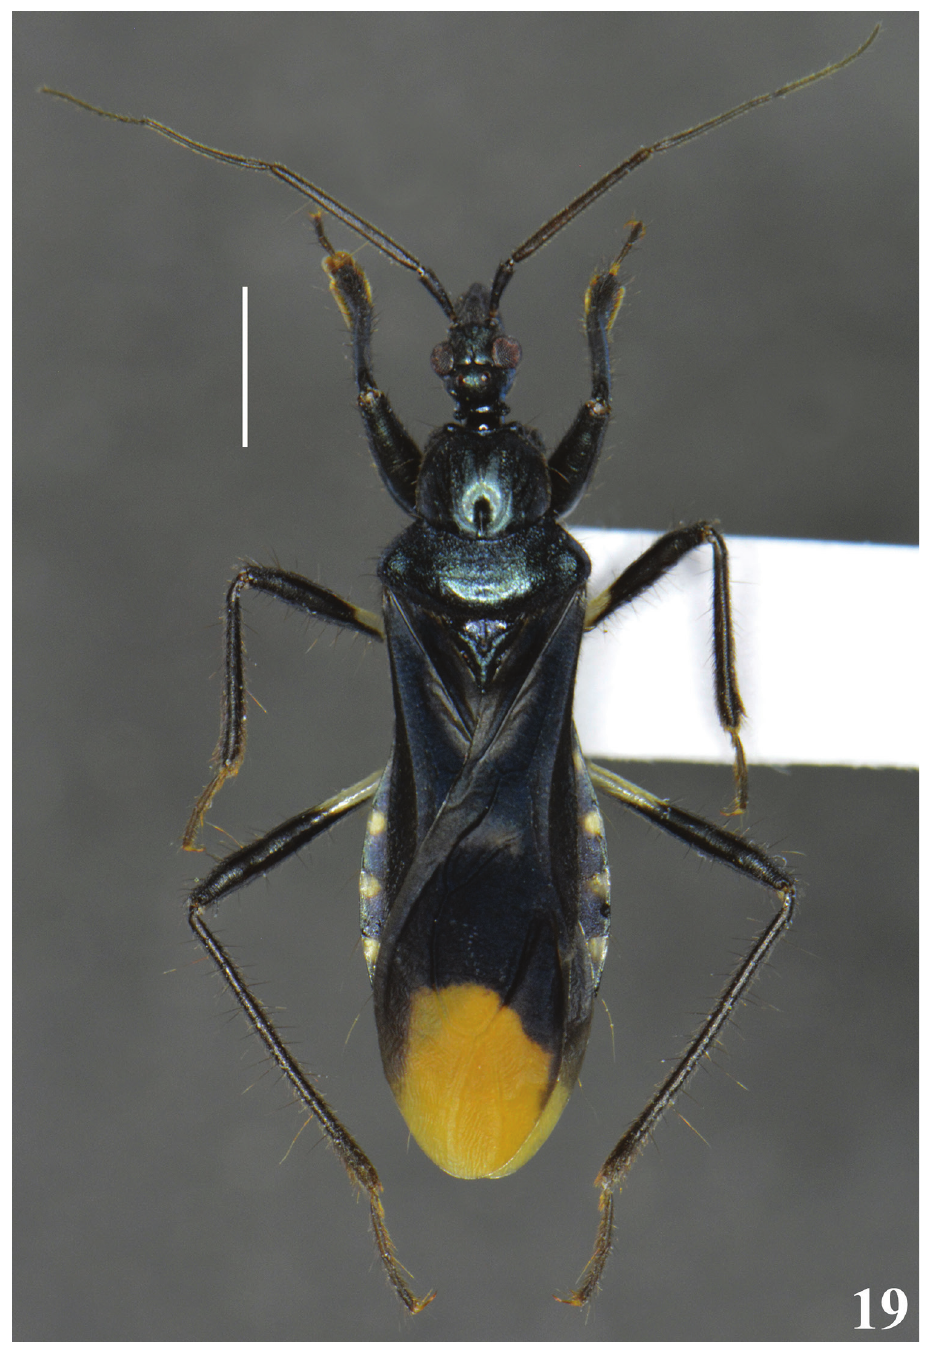
Figure 19. Zeraikia zeraikae sp. n., male holotype, dorsal view. Scale bar: 2.0